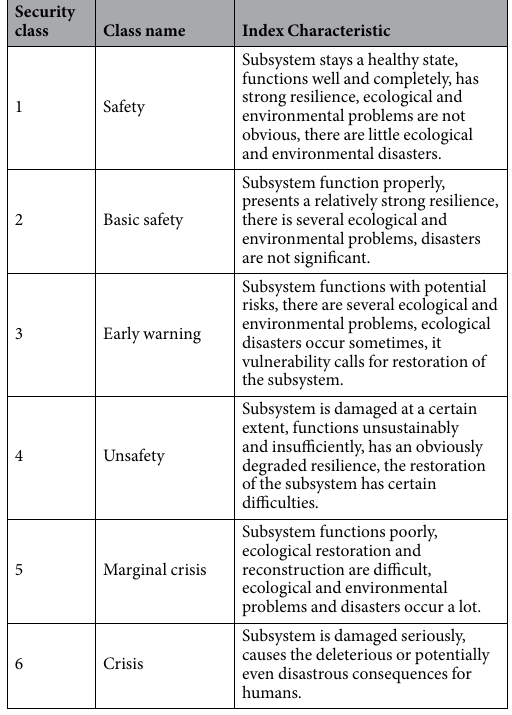
Table 4. Explanations on ecological and environmental security classes. Note: Explainations of six security classes were referenced to previous study 41–43 , which indicated different security states of the evaluation subsystem but with different descriptive